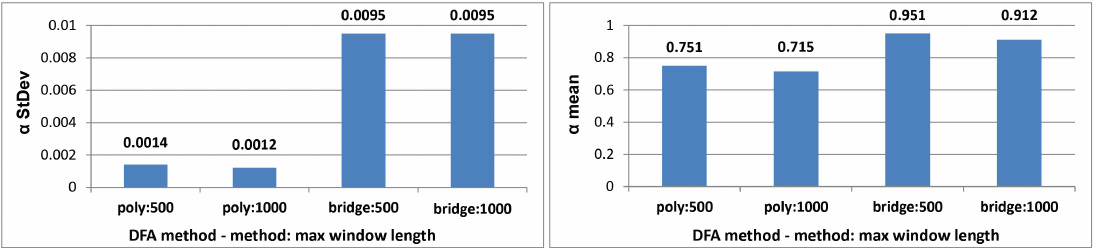
Figure 8. The standard deviation of the α parameter (on the left ) and its mean values (on the right ), calculated separately for each time series based on its corresponding sets: N, SG7, SG15, W8, W20, M5, M9, M15 and averaged over all 1334 time series, for different parameters of the DFA method, independently.